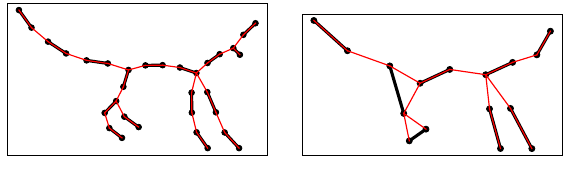
Figure 3. Merging nodes into pairs and graph simplification by replacing a pair of nodes with a single new one